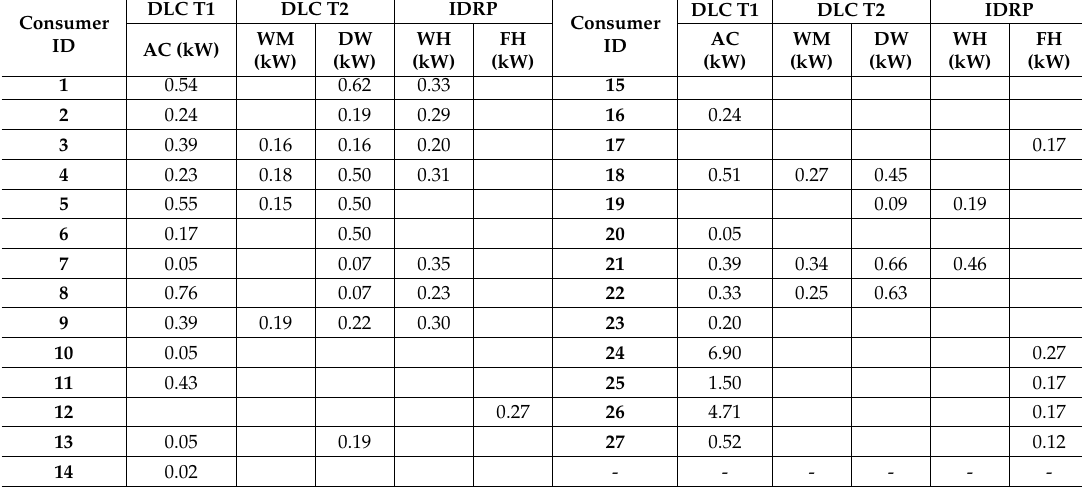
Table 2. Controllable devices involved in the DR programs (AC = Air Conditioner, WM =